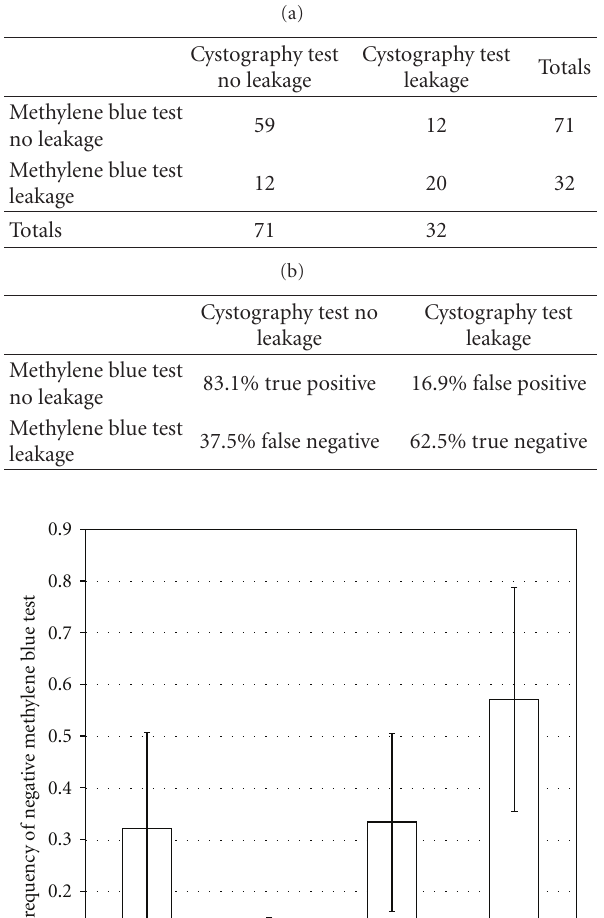
Table 2: Contingency table.